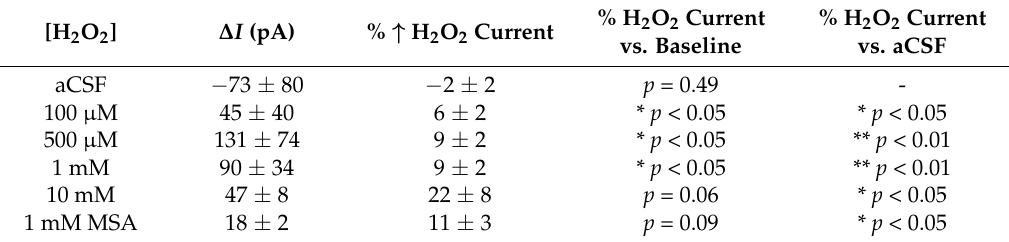
Table 1. Summary of in vivo characterisation data for H 2 O 2 biosensor co-implanted with microdialysis probe in the striatum of anaesthetised NOD SCID